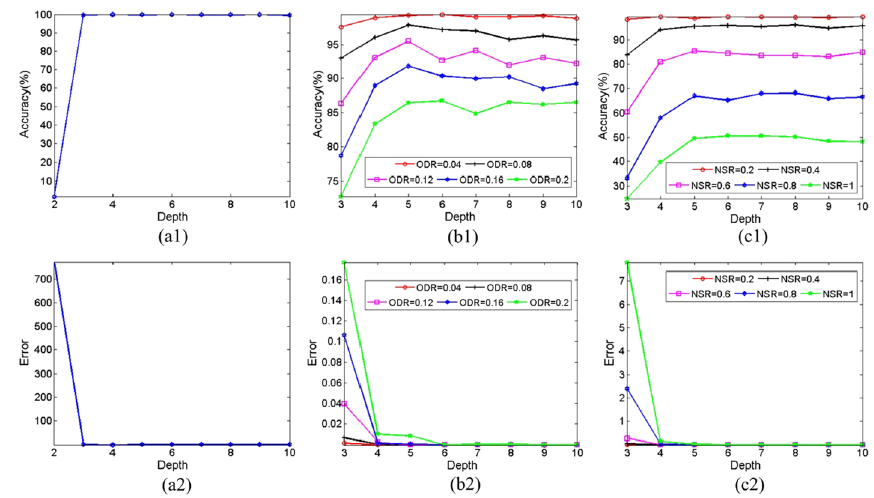
Fig. 4 Performance of AICT-DOPM with various depth. Point matching accuracy and matching error with respect to affine transformations, outliers and noise are shown in the first column ( a1 and a2 ), second column ( b1 and b2 ), and the last column ( c1 and c2